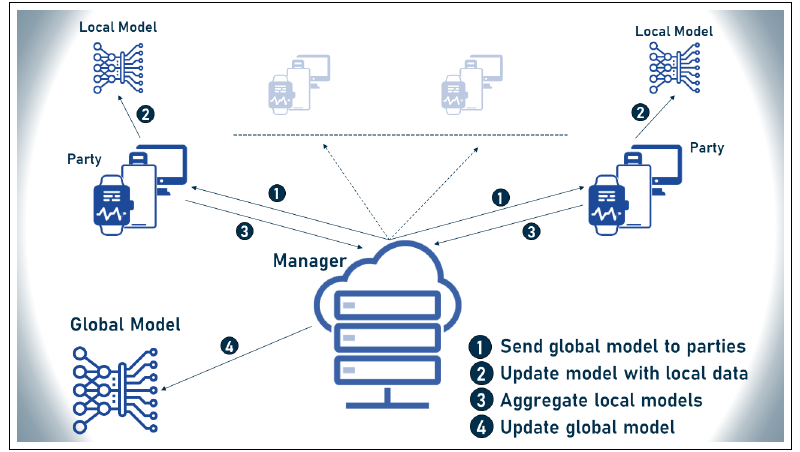
Figure 8. Federated machine learning classical